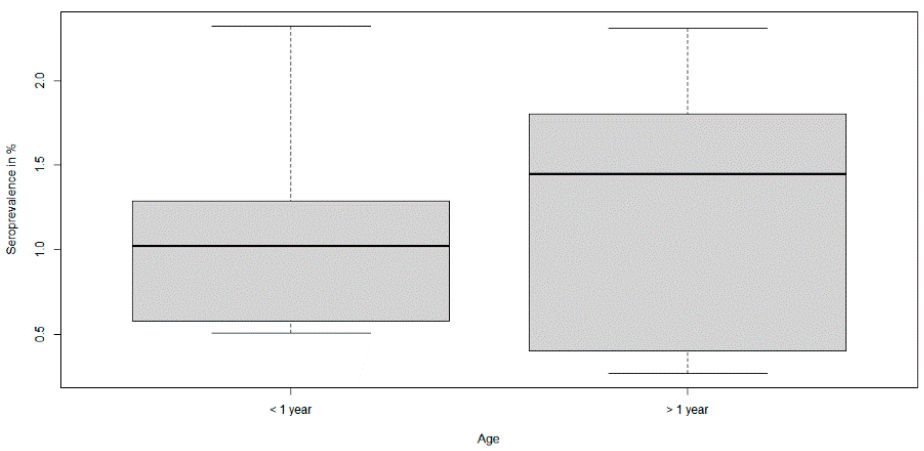
Figure 7. Seroprevalence estimates of hunted wild boar in the two different age classes. The horizontal lines that form the top of the boxes illustrate the 75th percentile. The horizontal lines that form the bottom indicate the 25th percentile. The horizontal lines that intersect the box represent the median seroprevalence per age class. Whiskers indicate maximum and minimum values that are no more than 1.5 times the span of the interquartile range and the open circles represent outliers, which are single values greater or less than the extremes indicated by the whiskers.